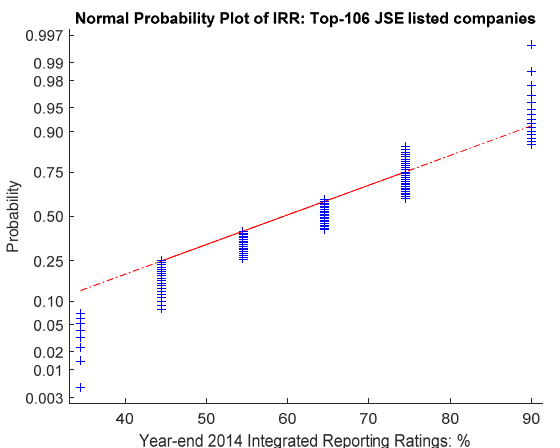
Fig. 1. Normal Probability Plot of IRR for top-106 JSE listed companies